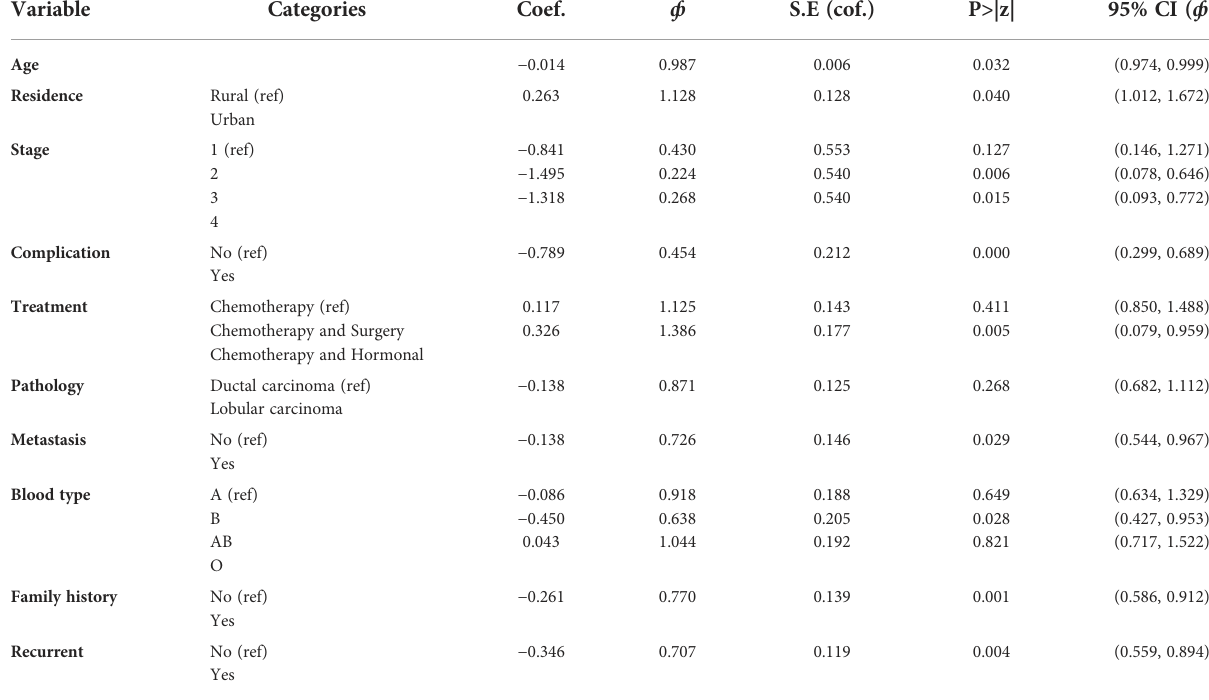
TABLE 9 Results of Weibull gamma shared frailty